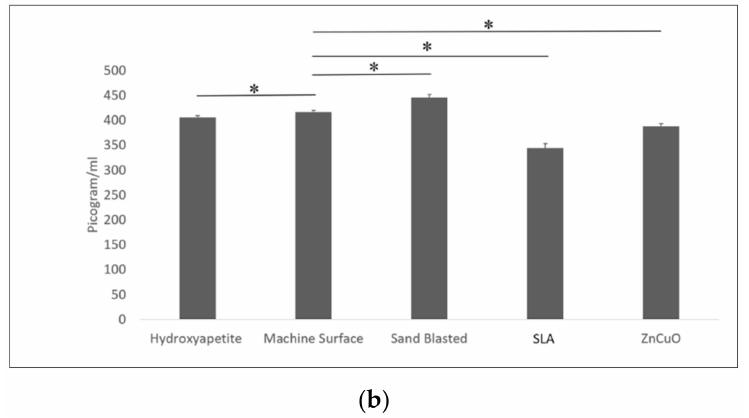
Figure 6. Macrophage-like cells seeded in culture wells on machined, sandblasted, SLA, and ZnCuO- coated titanium surfaces and hydroxyapatite discs, after 48 h incubation: ( a ) cell proliferation (XTT assay); ( b ) level of TNF- α cytokine produced by the cells, expressed as the mean + SD ( n = 9; asterisk indicates p <